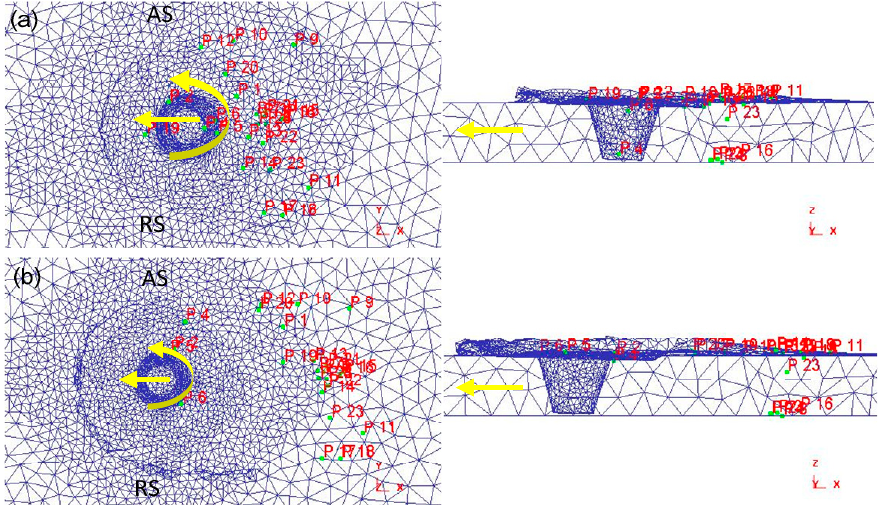
Figure 12. Material flow inside the tool needle during the welding phase. ( a ) Particle flow during welding; and ( b ) particle deposition behind the tool needle.